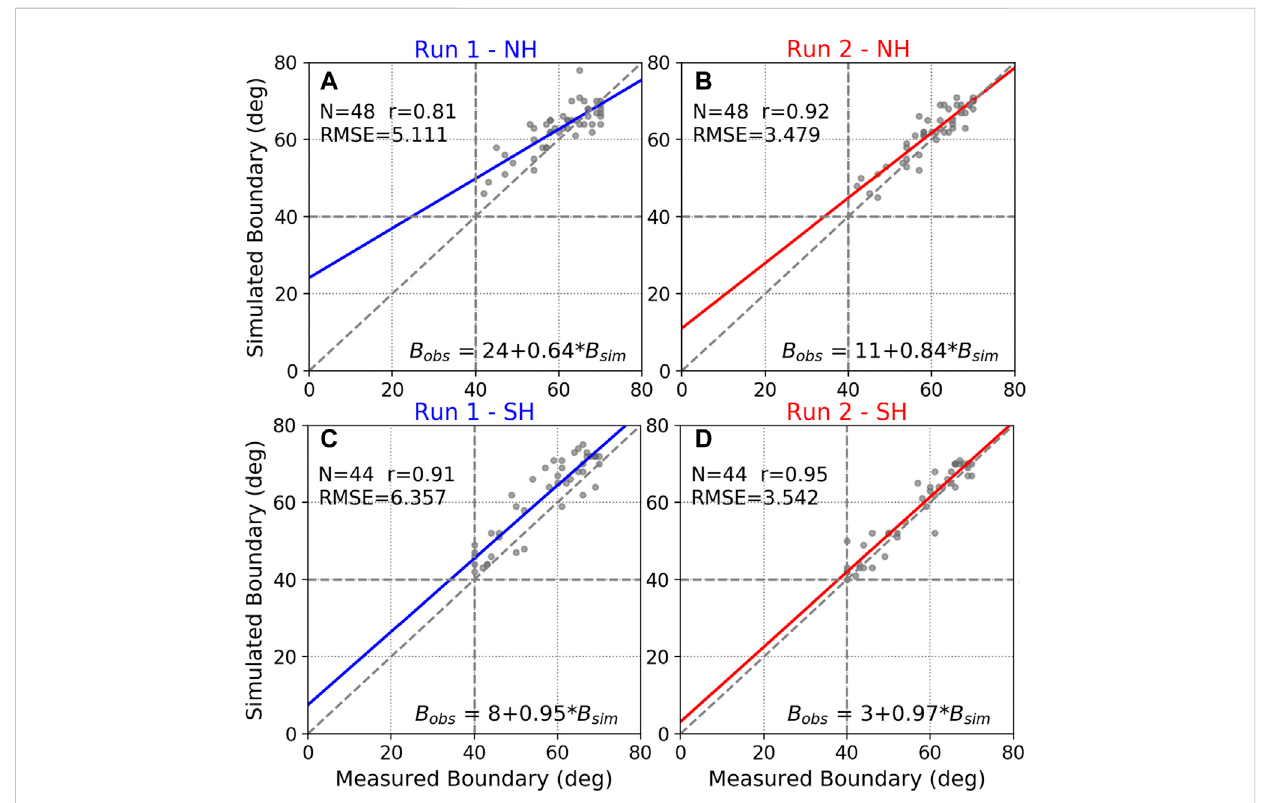
FIGURE 5 Scatter plots of the DMSP F16-measured ion convection equatorial boundary versus corresponding results from two GITM simulations run 1 (left, driven by empirical models) and run 2 (right, driven by data-based realistic patterns) during the October 8 – 9, 2012, geomagnetic storm for the northern (A, B) and southern (C, D) hemispheres. The straight lines represent the best- fi t line. The number of dots (N), correlation coef fi cient (r), and root mean square errors (RMSE) are shown in the left-up corners, while the linear fi tting equation is shown in the lower right corners.